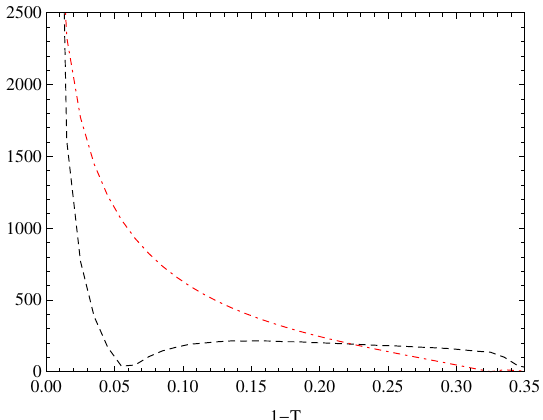
¯ B ( y, µ r ) β · β 0 and conformal term 0 ¯ B ( y, µ r ) con , and the dot-